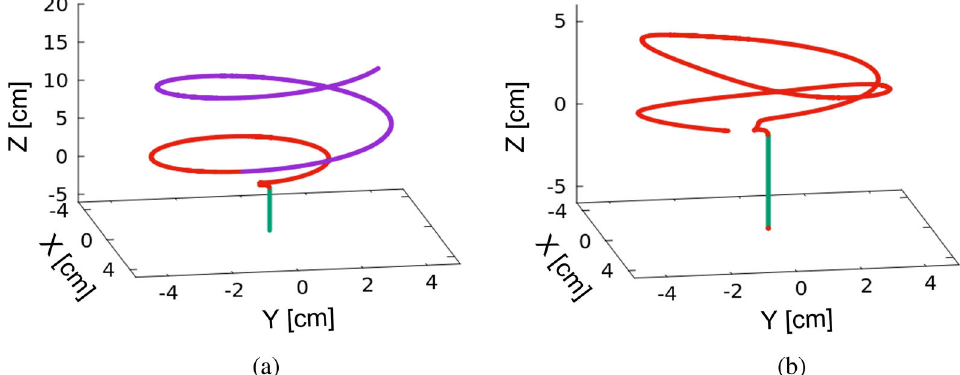
FIG. 1. Particle orbits within an eCRA cavity. Example (a) is for a cavity with radius R ¼ 6 . 0 cm and length L ¼ 6 . 113 cm, showing a nonreflecting orbit; while for (b), R ¼ 7 . 0 cm and L ¼ 5 . 84 cm, showing an orbit that reflects within the cavity. Both are for injected ¼ 100 MV = m. In (a) the guide magnetic field B ¼ 0 . 914 T, while in (b) B ¼ 0 . 650 T. The particle energies of 100 keV, and for E w o o electron trajectories are in green (before the cavity), red (in the cavity) and violet (after the cavity). Note that the orbit shown in (a) achieves full acceleration to 10.13 MeV in only about one turn.